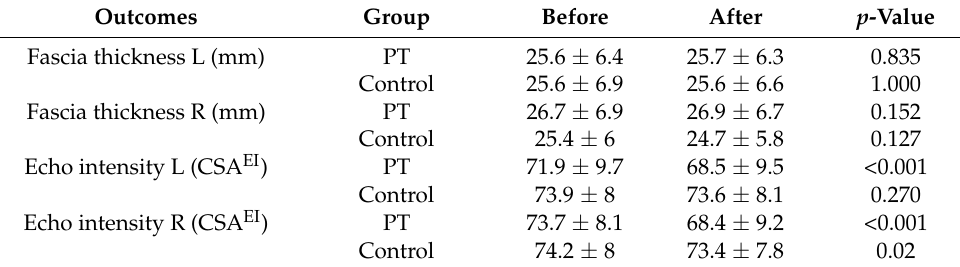
Table 2. Post differences of ultrasound data within groups using paired-sample t -test. Outcomes Group Before After